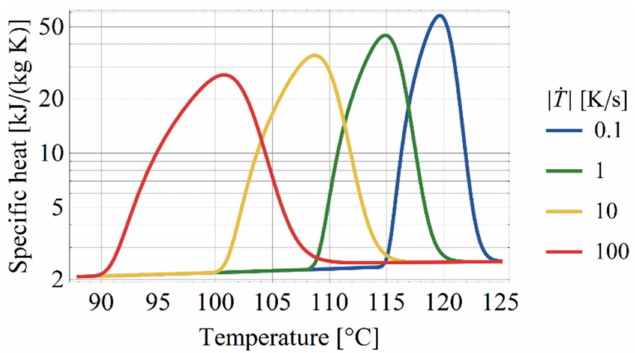
Figure 4. Apparent specific heat at constant cooling with